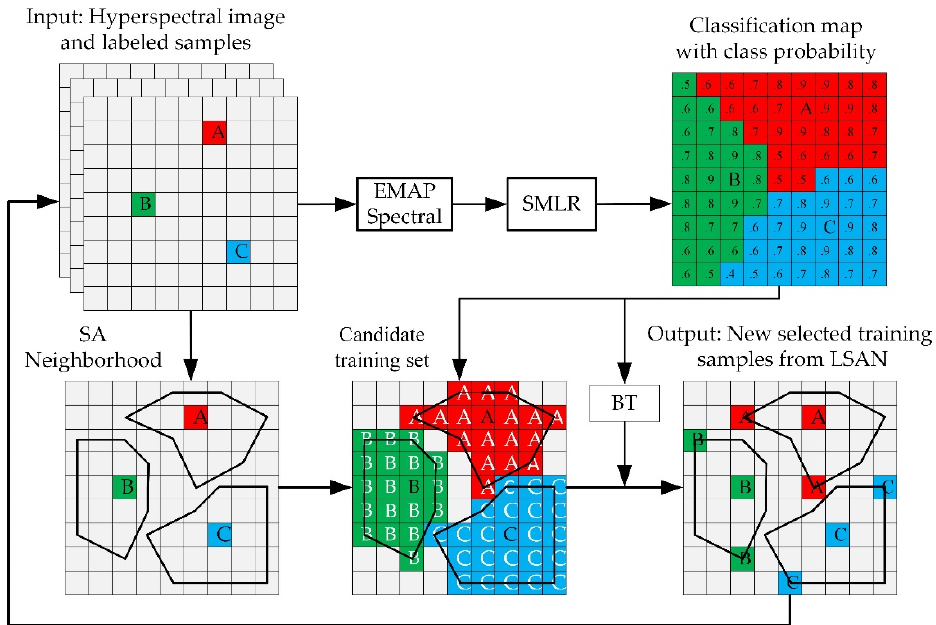
Figure 3. Flowchart for the selection of unlabeled samples from labeled samples’ SA neighborhood (LSAN).